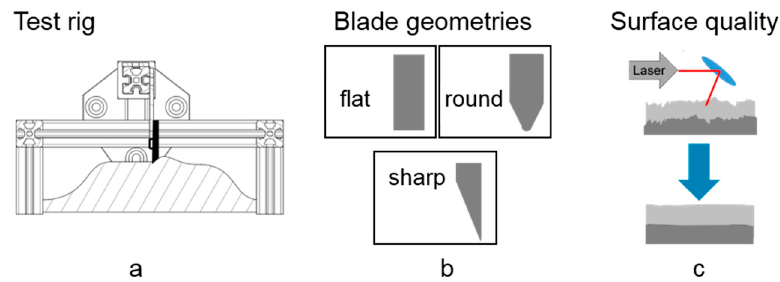
Figure 7. ( a ) Test rig; ( b ) different blade shapes; ( c ) possible powder bed and specimen surface profiles.